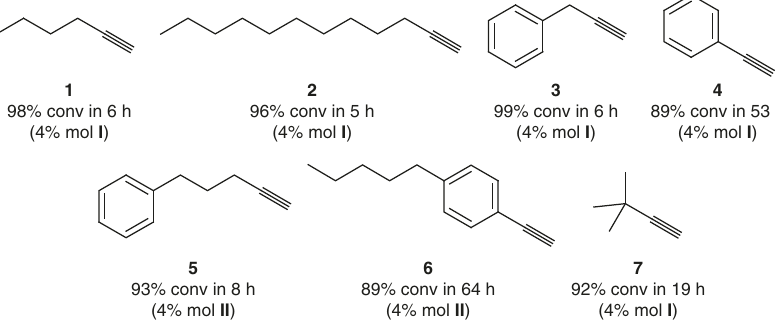
Fig. 2 Scope of the Au n -catalyzed alkyne hydration reaction. Alkenes bearing medium to long alkyl and aromatic side chains able to interact with gold subnanoclusters ( 1 – 3 , 5 ) react much faster than phenylacetylene derivatives ( 4 ) and ( 6 ). Shorter, more rigid side chains such as the tert-butyl group attached to ( 7 ) allow more discrete accelerations. The precatalyst loadings leading to highest conversion in each case are shown